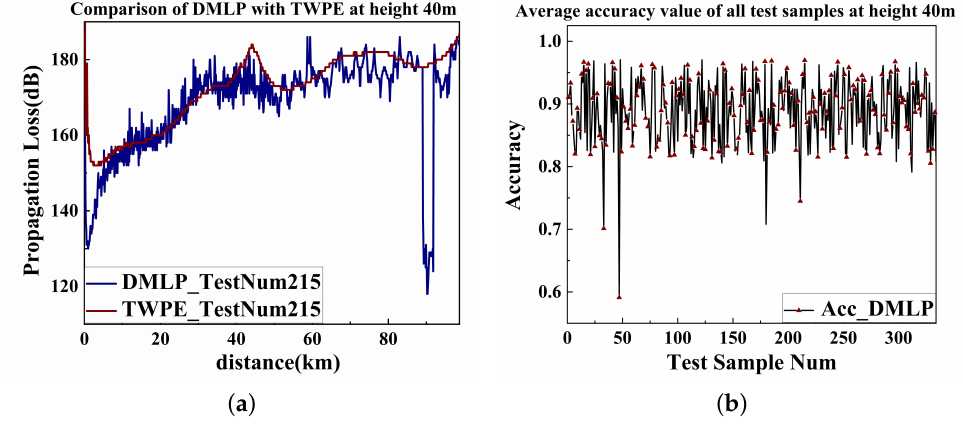
Figure 30. DMLP prediction at a height of 40 m and accuracy distribution. ( a ) PL prediction using DMLP at an antenna height of 40 m. ( b ) DMLP of PL at a height of 40 m accuracy on test